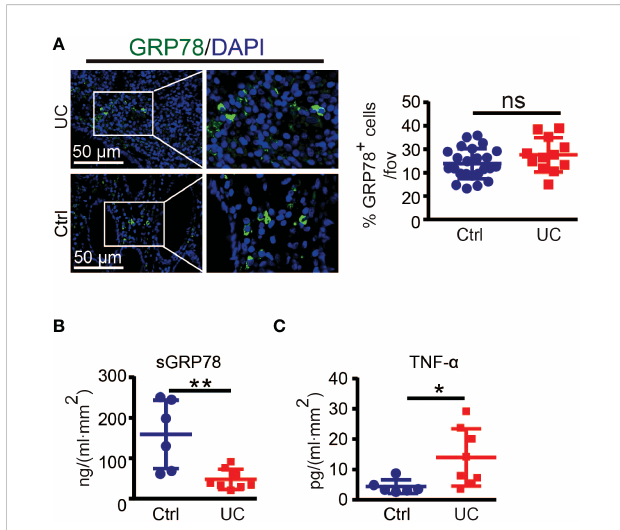
FIGURE 1 GRP78 is decreased in the intestinal mucosa of UC patients. (A) Representative immuno fl uorescent staining of GRP78 in human colonic tissues (left). Scare bar: 50 m m. The quantitative results about the percentage of GRP78 immunoreactive cells per fi eld of view was shown in right. sGRP78 (B) and TNF- a (C) levels in the supernatants of mucosa punches collected from UC (n=8) and non-colitic control (n=6) patients. The levels were normalized to colonic surface area. Results are expressed as mean ± standard error of mean (SEM). ns, not signi fi cant. * p < 0.05, ** p <